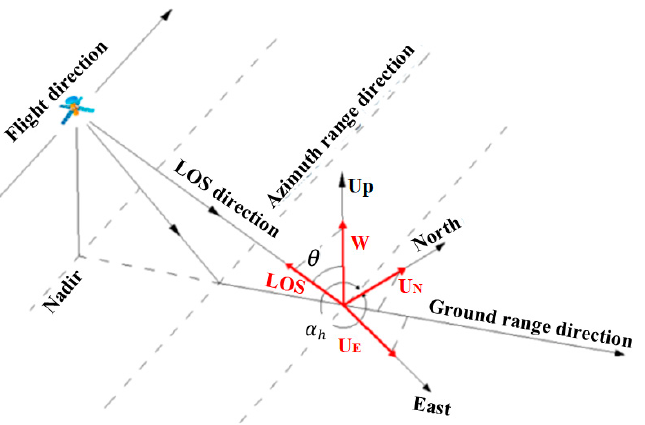
Figure 3. Geometric relationships between the LOS displacement and the 3-D displacements of ground points.